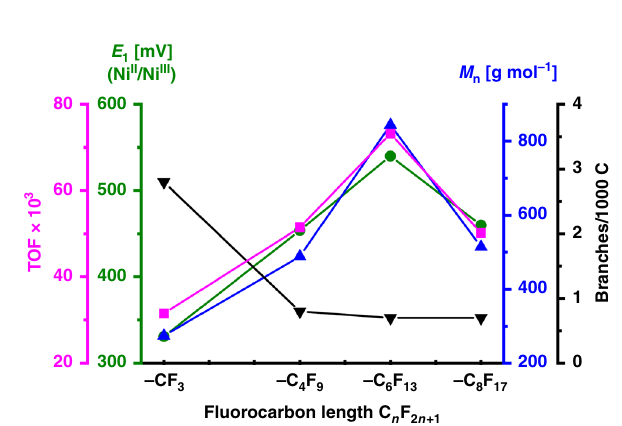
Fig. 3 Comparison of the experimental data from polymerization experiments with different catalyst precursors. Catalytic activity (TOF, magenta line), forward peak potential determined via cyclic voltammetry of precatalysts ( E 1, green line), molecular weight (blue line) and branching values (black line) of formed polyethylenes and fl uorocarbon chain length in precatalysts ’ structures ( 1/Pyr ) given. Experimental data from experiments at 30 °C in toluene (entries 1, 4, 7, 10, Table